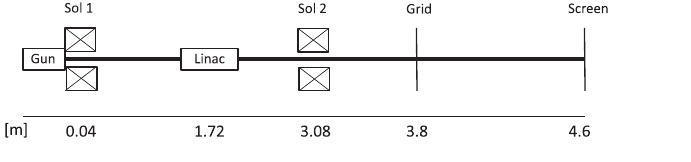
FIG. 8. A schematic of the Pegasus beamline.